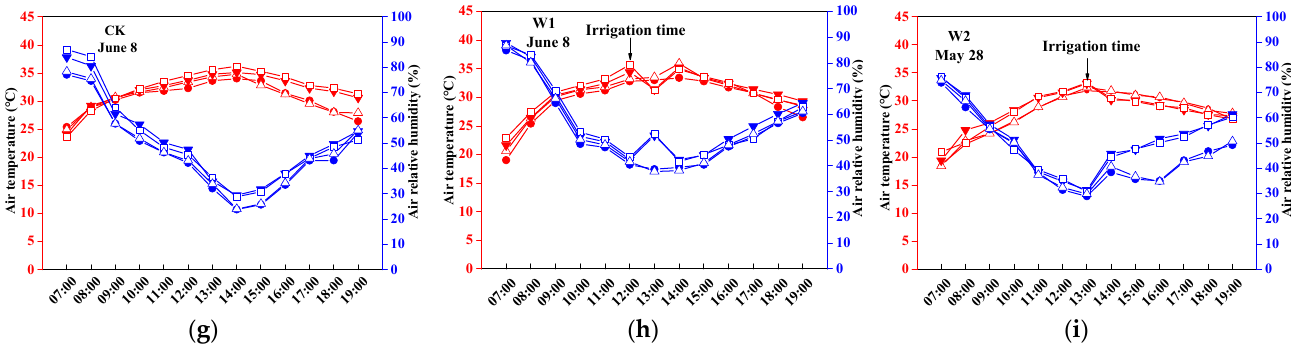
Figure 5. Time course of air temperature and air relative humidity with ( a ) CK, ( b ) W1, ( c ) W2 treatments on 21 May, ( d ) CK, ( e ) W1, ( f ) W2 treatments on 28 May, and ( g ) CK, ( h ) W1, ( i ) W2 treatments on 8 June when dry-hot wind occurred in 2019, respectively. W1, W2, and CK represent 2.5 mm, 5 mm, and no irrigation treatments during dry-hot wind condition, respectively.